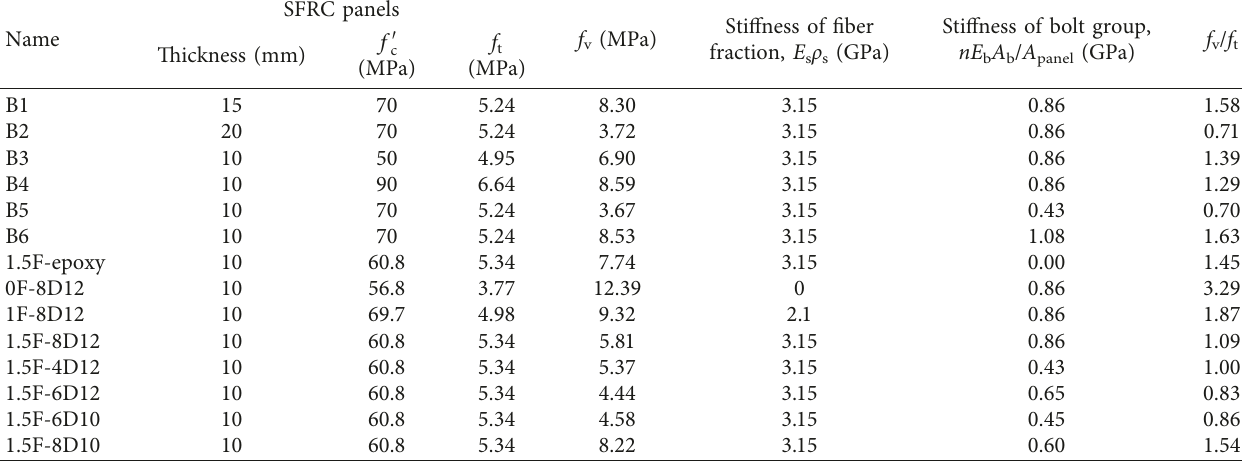
Table 7: Calculation for the regressing equation of average tensile strength perpendicular to the diagonal crack. Name